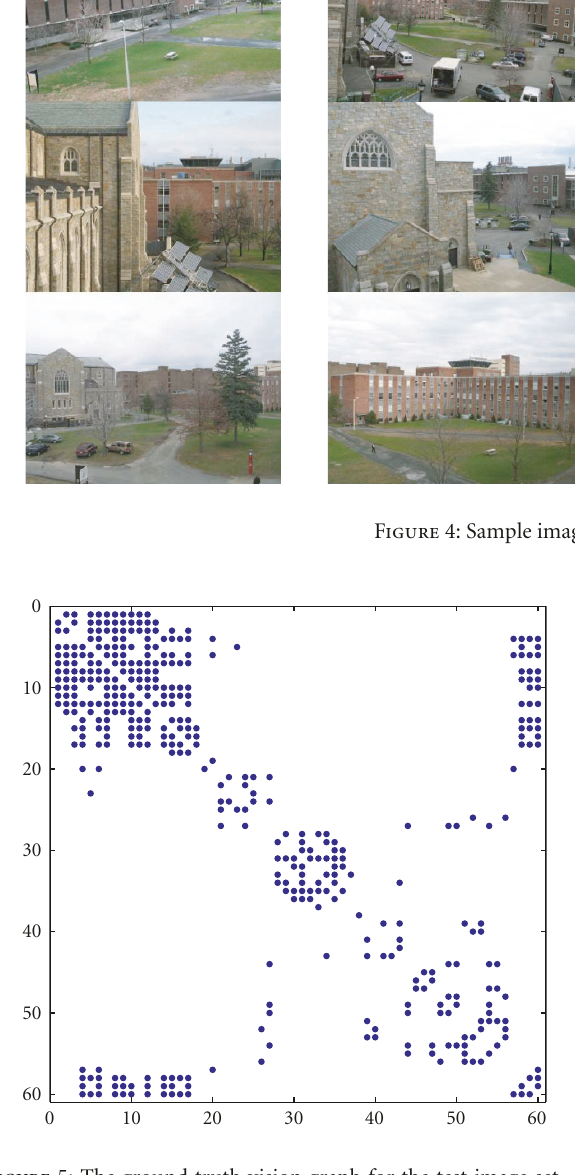
Figure 5: The ground truth vision graph for the test image set. A dot at ( i , j ) indicates a vision graph edge between cameras i and j